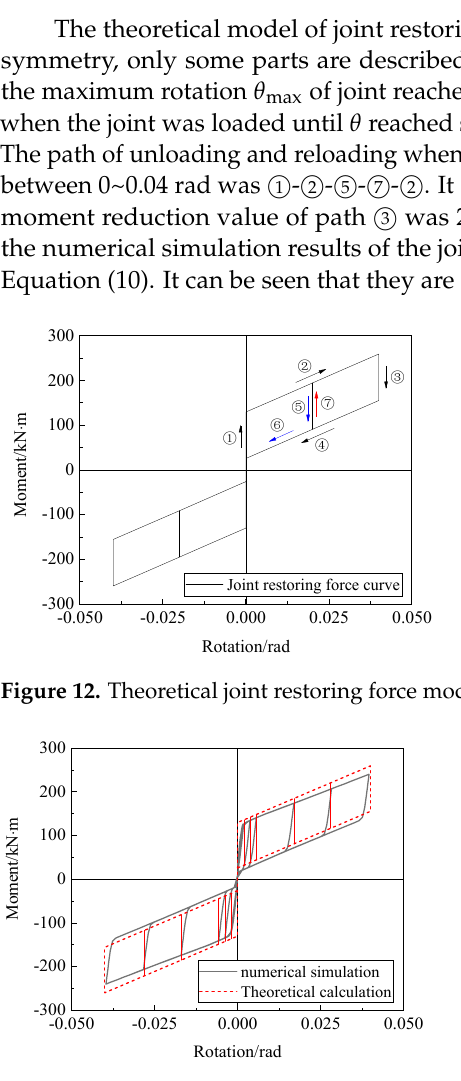
Table 3. Parametric settings of J1-0~J1-5.